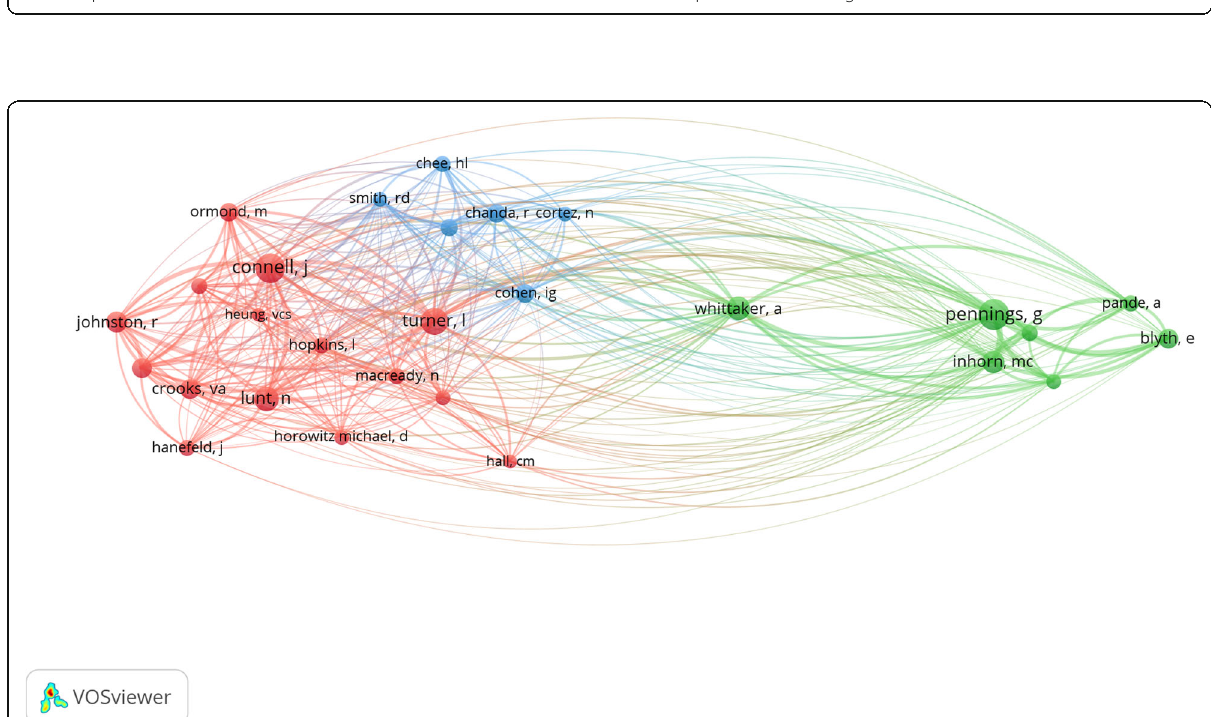
Fig. 8 Citation network of policy-related publications on medical tourisms. Note: The figure shows how frequently publications (with at least 15 citations) cite or get cited by others in the network. Nodes depict publications and their linkages convey citation relationships. Larger nodes indicate publications with more citations. Publications with close citation relationships are clustered together in nodes of the same color